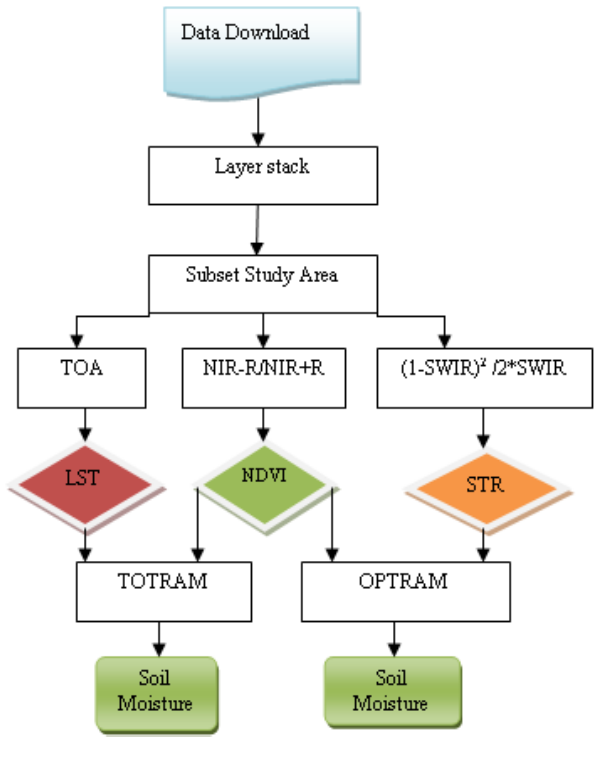
Figure 2: Methodology flow chart